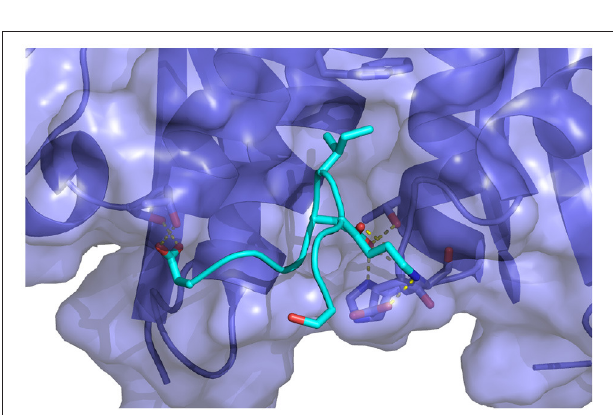
FIGURE 10 | Key interactions observed in the conformational ensemble at low binding energies (around 120 kcal/mol) of the complex of HIV integrase with − the linear peptide. Notable differences relative to the complexes with the cyclic peptides include the participation of Asp369 with α 2 helix residues of HIV integrase.